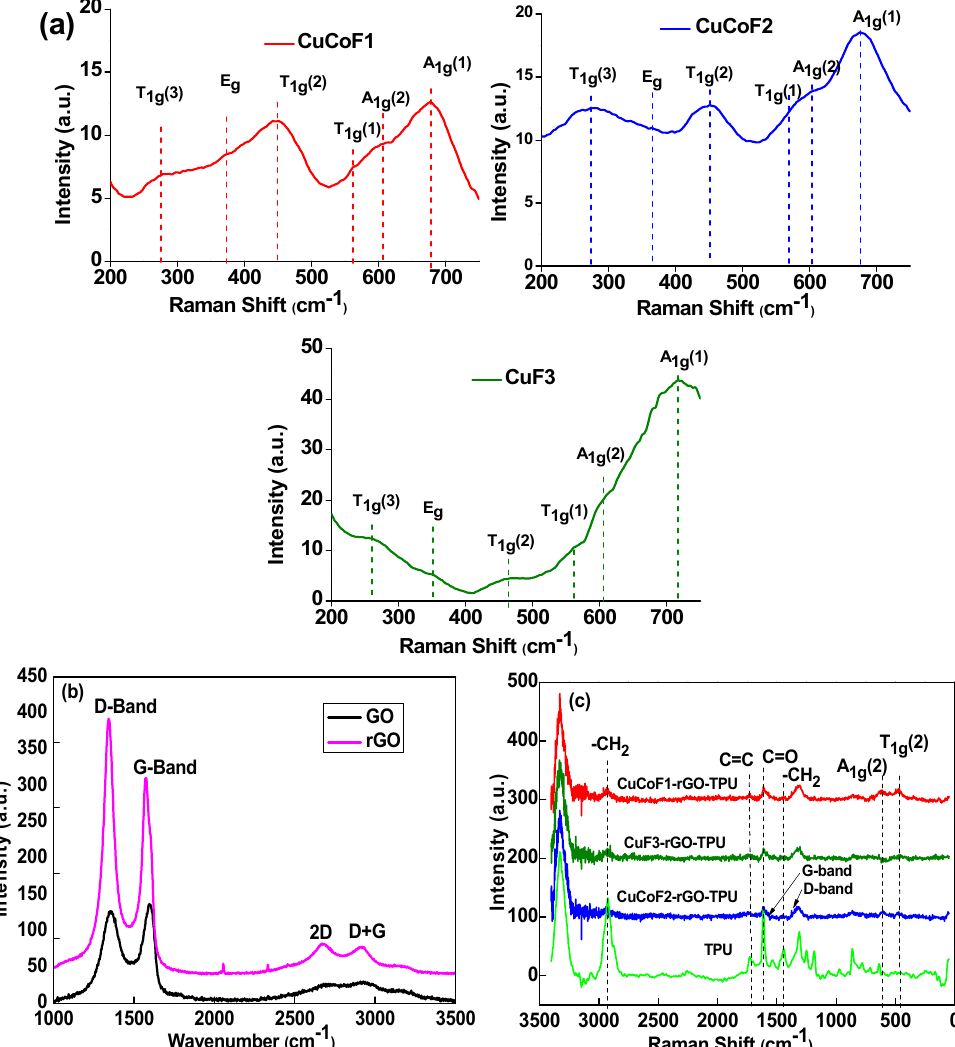
Figure 2. Raman Spectra of ( a ) CuCoF1, CuCoF2 and CuF3 nanoparticles ( b ) GO and rGO ( c ) CuCoF1, CuCoF2, and CuF3 nanoparticles based nanocomposites along with rGO in TPU matrix.